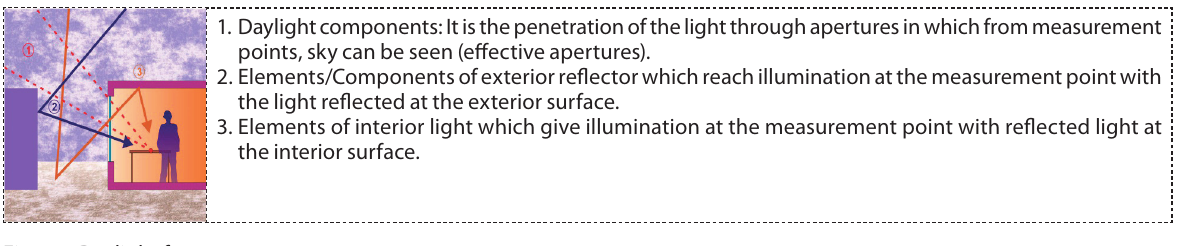
Fig. 3. 3 Daylight factor components Source: Gretz 2002.